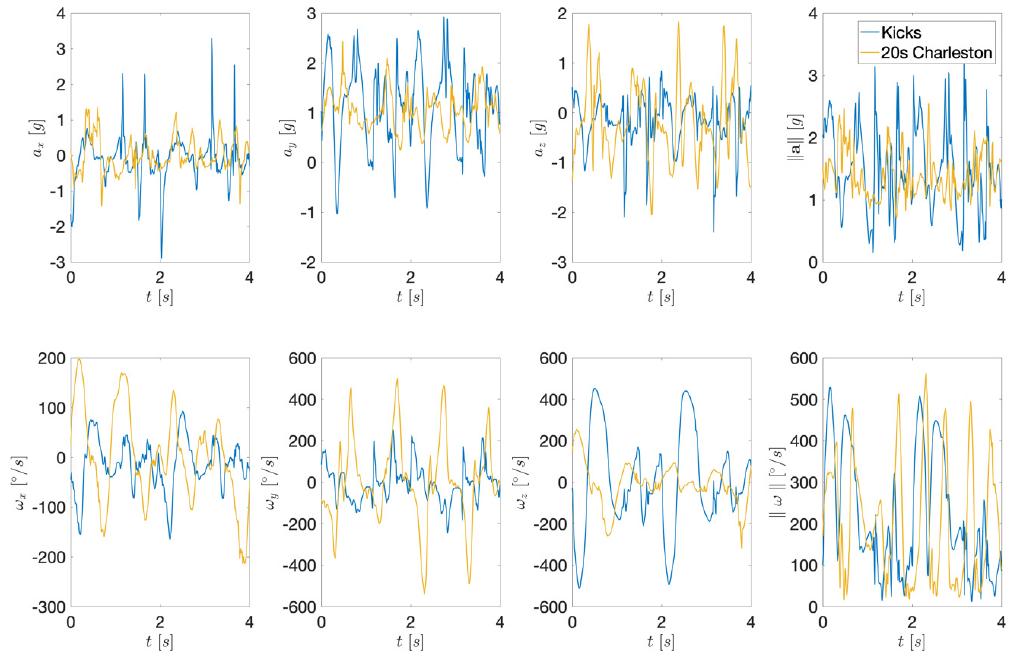
Figure 2. Examples of acceleration (first row) and angular velocity (second row) of right leg motion during two solo jazz moves. The first three columns show the 3D projections and the last column illustrates the magnitudes.